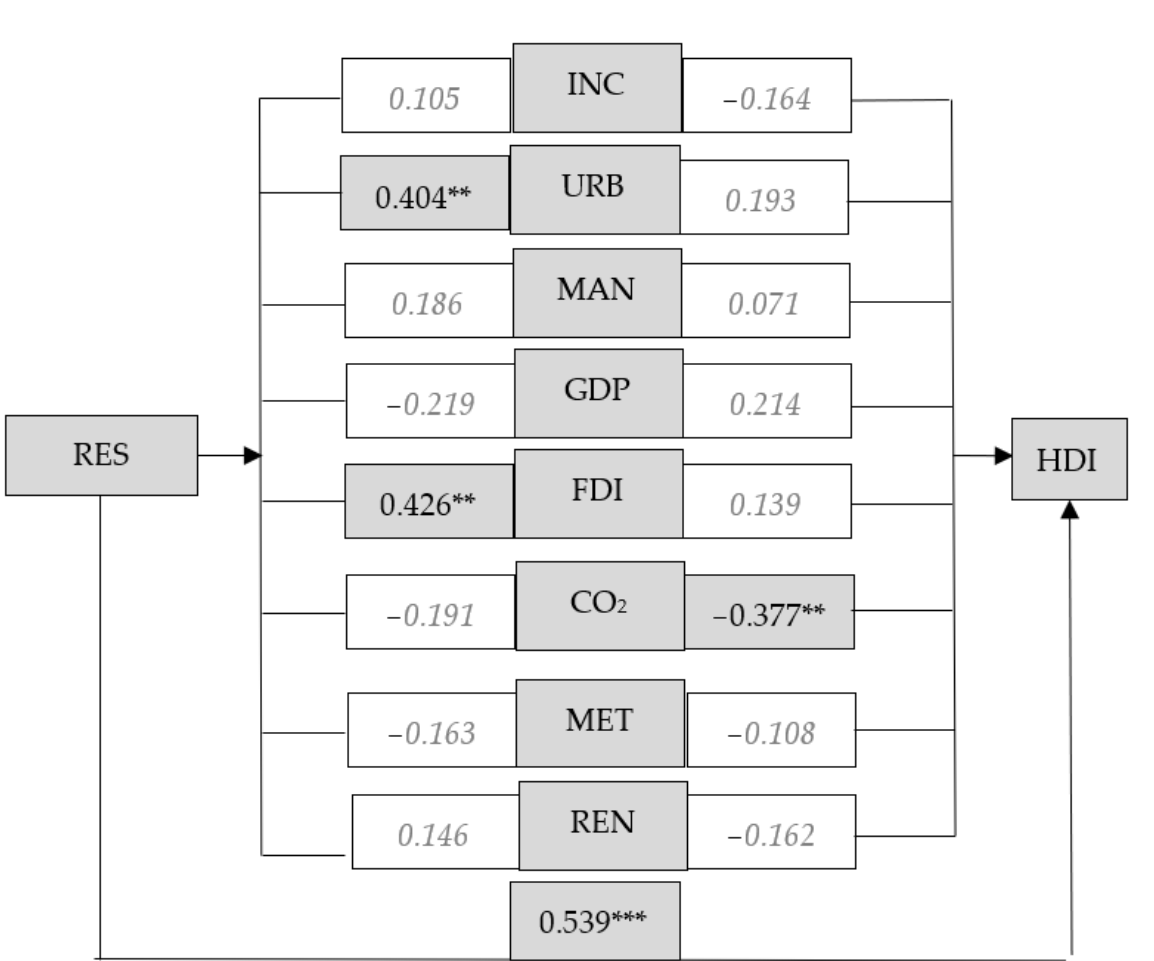
Figure A1. Role of the residential energy use per capita in explaining HDI of EU member states, 2000. Note: the insignificant values are marked with italics and grey. ** 5% significance level, and *** 1% significance level.